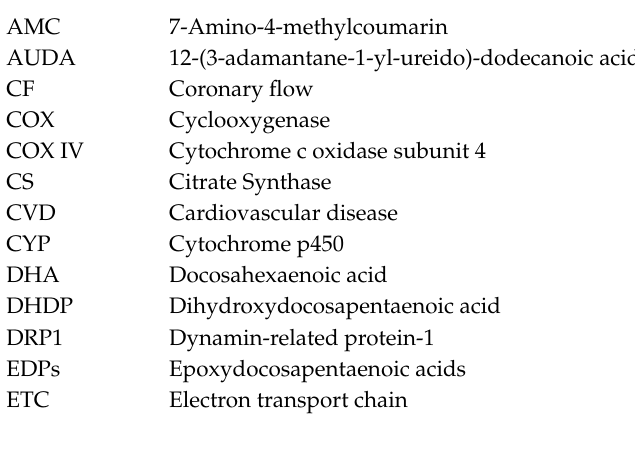
Figure S3: Spectra of methyl 15-(3-pentyloxiran-2-yl)pentadec-4( Z )-enoate, Figure S4: Spectrum of ( Z )-15-(3-pentyloxiran-2-yl)pentadec-4-enoic acid (SA-26), Figure S5: Spectra of methyl docos-16( Z )-en-4-ynoate, Figure S6: Spectra of 1-(18-(( tert -butyldiphenylsilyl)oxy)octadec-5( Z )-en-1-yl)-3-ethylurea, Figure S7: Spectra of 1-ethyl-3-(18-hydroxyoctadec-5( Z )-en-1-yl)urea, Figure S8: Spectra of 18-(3-ethylureido)octadec-13( Z )-enoic acid (AS-27), Figure S9: Spectrum of ( Z )-15-(3-pentyloxiran-2-yl)pentadec-7-enoic acid